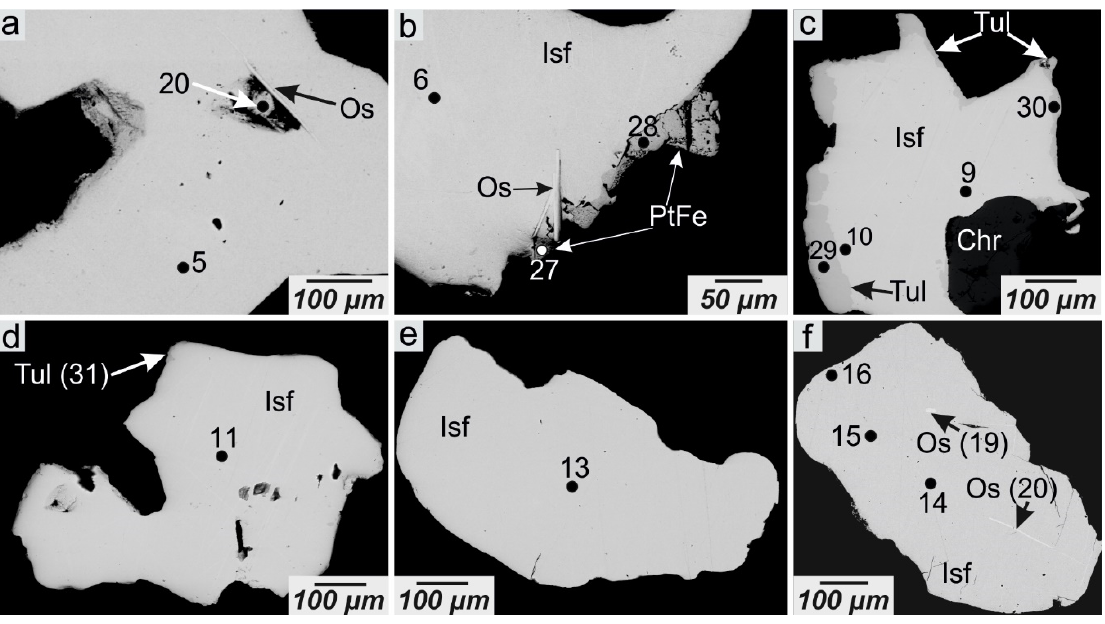
Figure 6. BSE images (SEM) of Pt-Fe aggregates from Vershinniy eluvial ( a , b ), Travyanistyi proximal ( c , d ) and Glubokinskoe distal ( e , f ) placers. The number of points corresponds to the data in Table 1 for isoferroplatinum (No 5–6, 9–11, 13–16) and ferroan platinum (No 20), in Table 2 for tetraferroplatinum–tulameenite (No 27–31) and in Table 3 for osmium (No 19, 20). Isf—isoferroplatinum, PtFe—tetraferroplatinum Tul—tulameenite, Os—osmium, Ir—iridium, and Chr—chromite. The a and b photo were published in [25]. Table 2. Compositions of tetraferroplatinum group minerals from the chromite-platinum ore zones of the Svetloborsky massif and associated